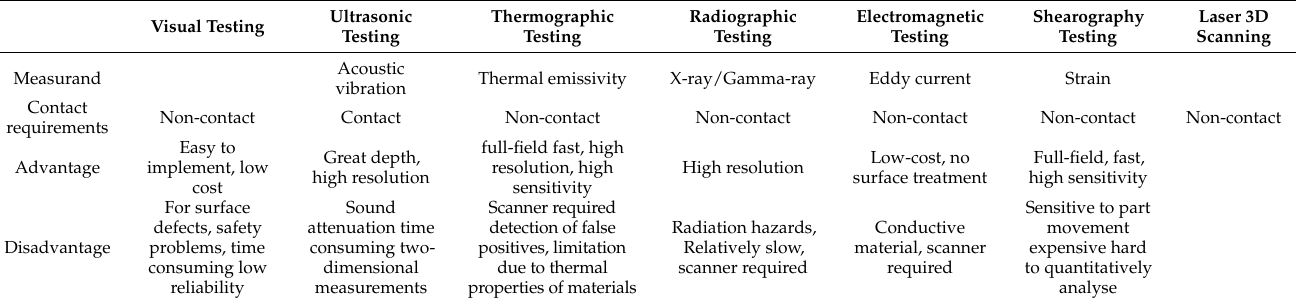
Table 3. Comparison of contemporary NDT methods for